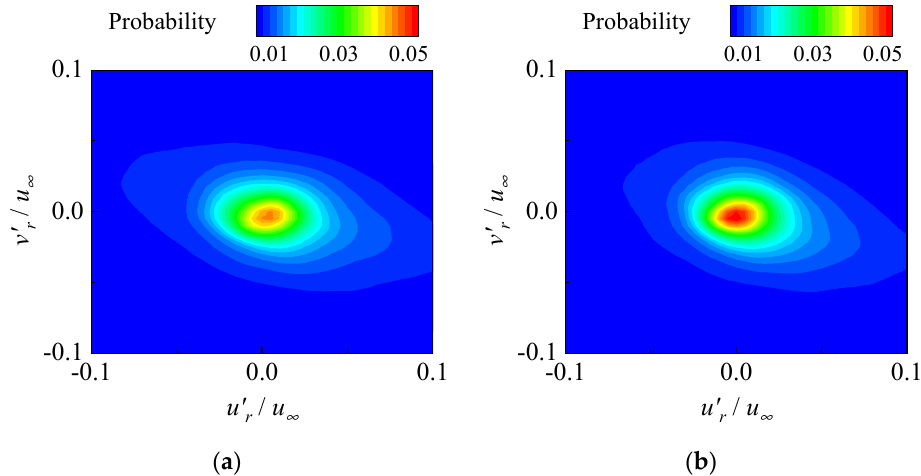
Figure 16. Relative probability of flow and wall-normal fluctuation velocity: ( a ) None; ( b ) Control.